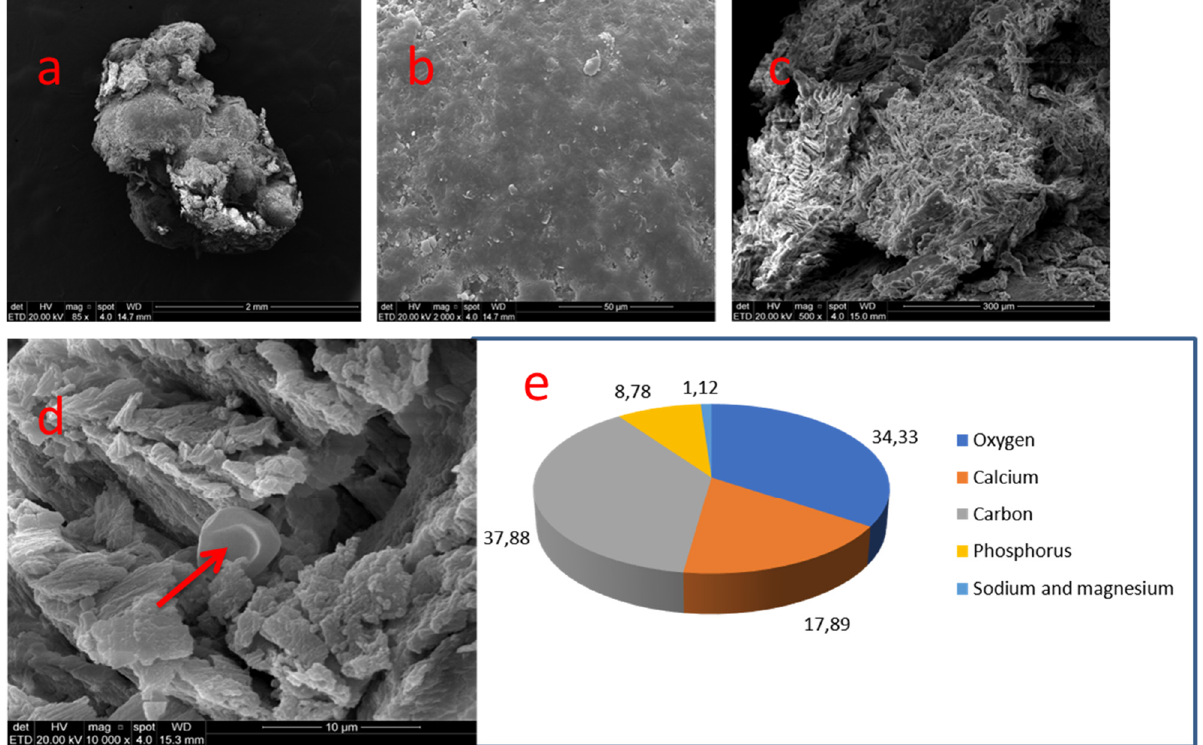
Figure 5. Sample 03: ( a ) Irregular topography of the coronal nodule (SEM, 85×); ( b ) Smooth and compact surface (SEM, 2.000×); ( c ) porous zone and irregular topography (SEM-500×); ( d ) disorganized crystal formation. Presence of erythrocyte (arrow) (SEM, 10.000×); ( e ) Results of chemical analysis of the sample with X-ray dispersive energy spectroscopy (EDX).